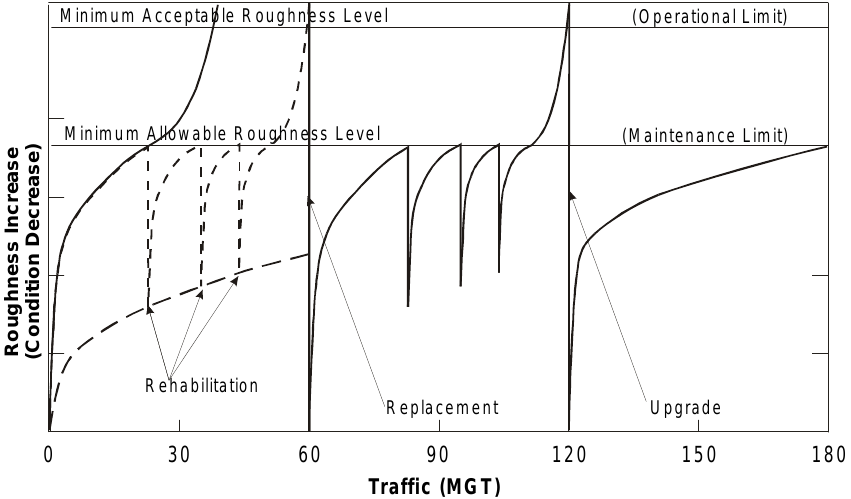
Figure 1. Hypothetical degradation curve of track geometry [Ebersohn and Ruppert,